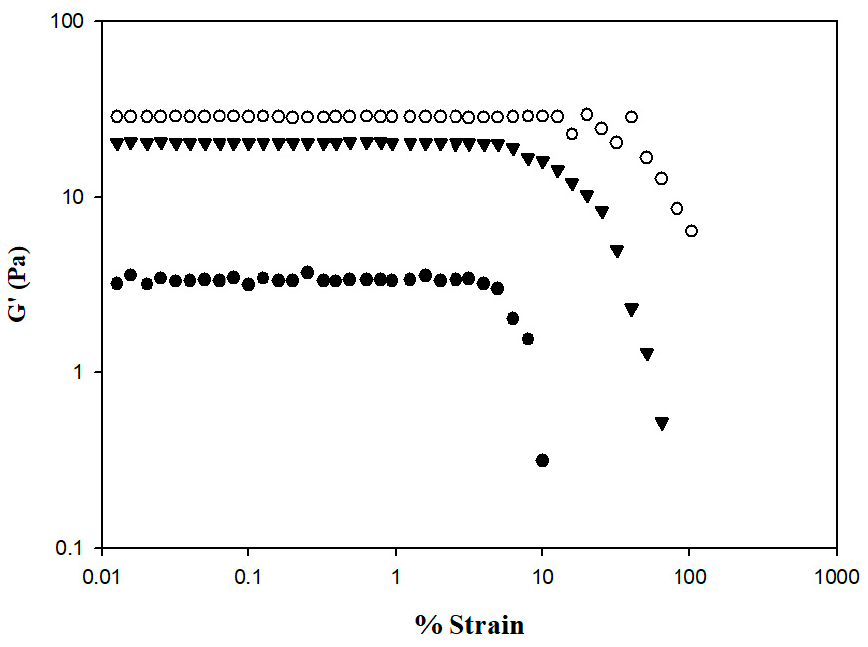
Figure 7. Storage modulus % strain profile of thickened SD by incorporating different commercial thickeners. Tapioca starch ( ● ); hydroxypropyl distarch phosphate ( ○ ); xanthan gum ( ▼ ). thickeners. Tapioca starch ( • ); hydroxypropyl distarch phosphate (